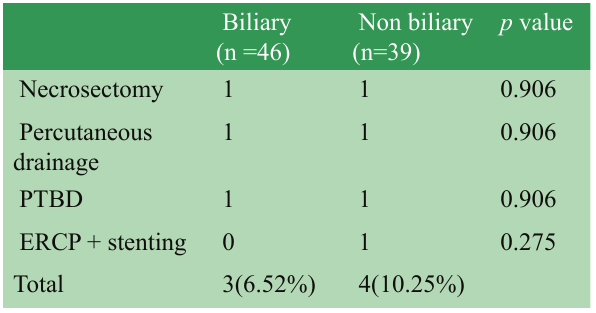
Table 6: Incidence of systemic complications in Biliary and Non biliary pancreatitis